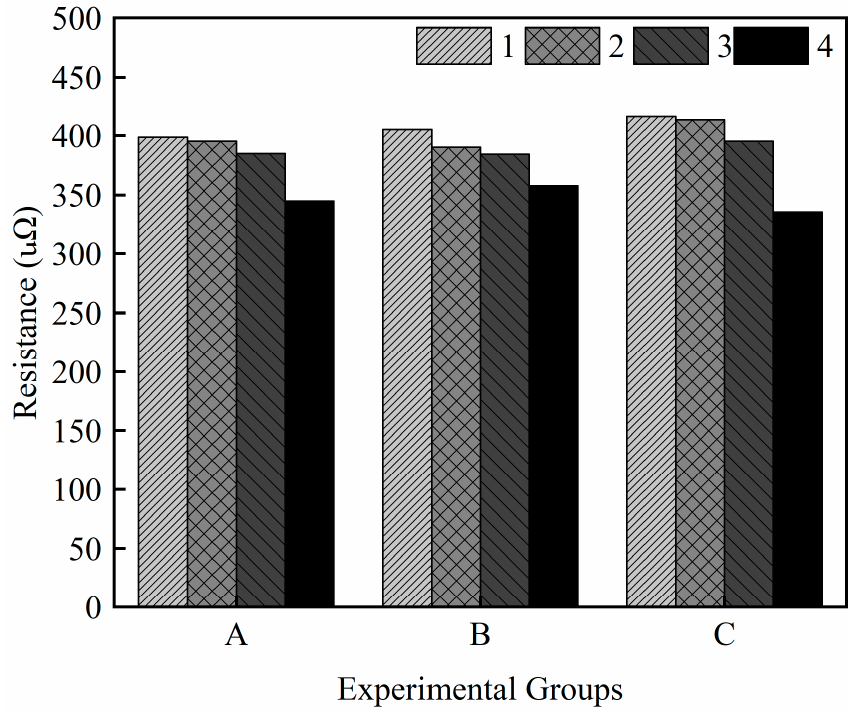
Figure 15. Electrical contact resistance.